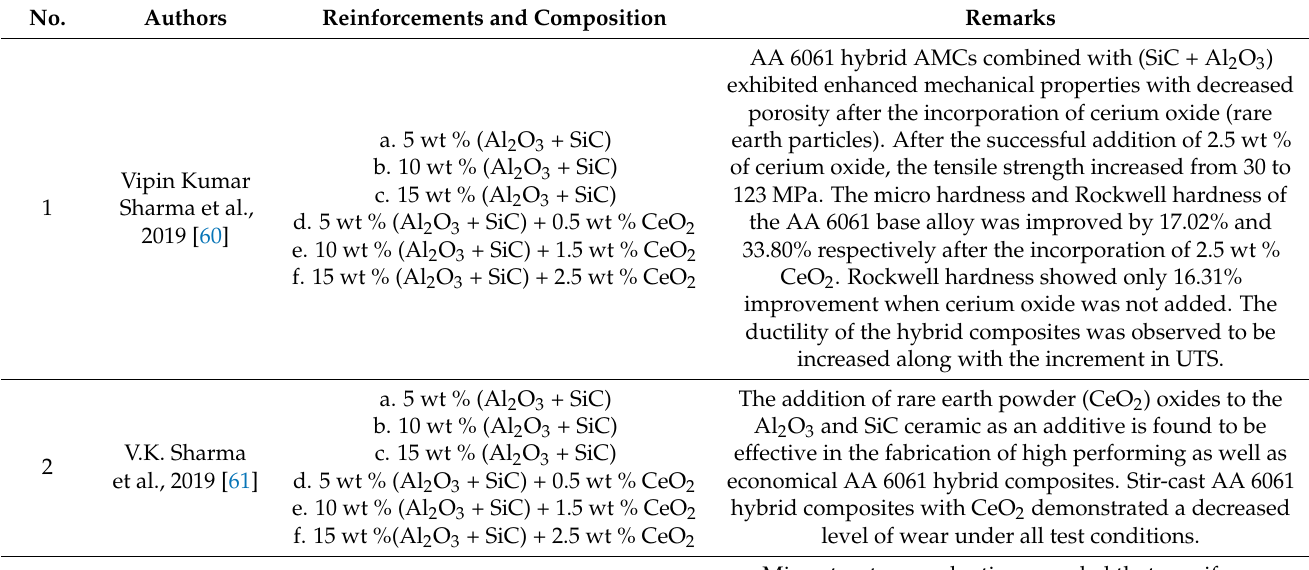
Table 3. Summary of research studies in the stir-casting process of hybrid AA 6061